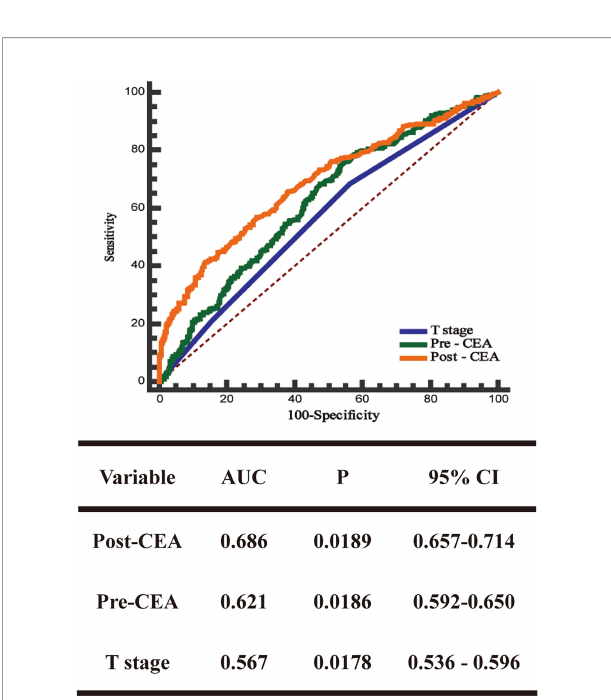
FIGURE 3 | The receiver operating characteristics (ROC) curves and the area under the curves (AUCs) of postoperative CEA, preoperative CEA, and T